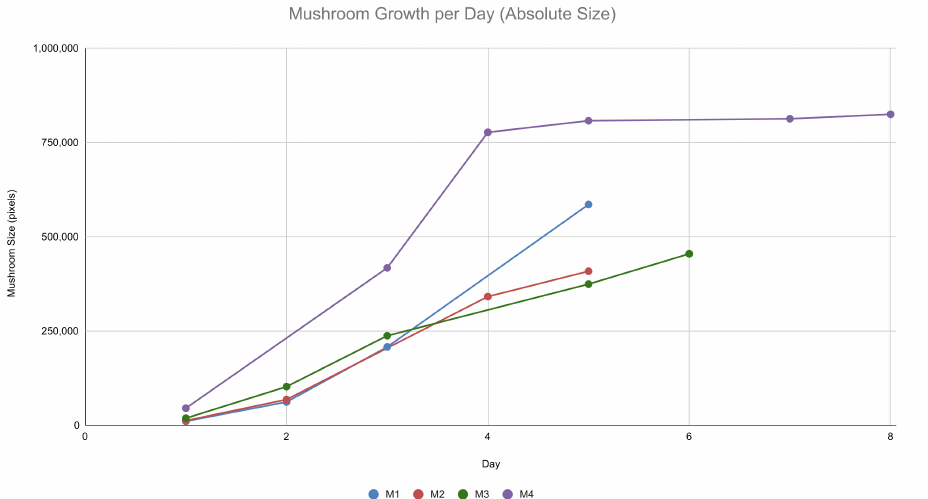
Figure 10. Comparing the absolute size of the growth rate of mushrooms.